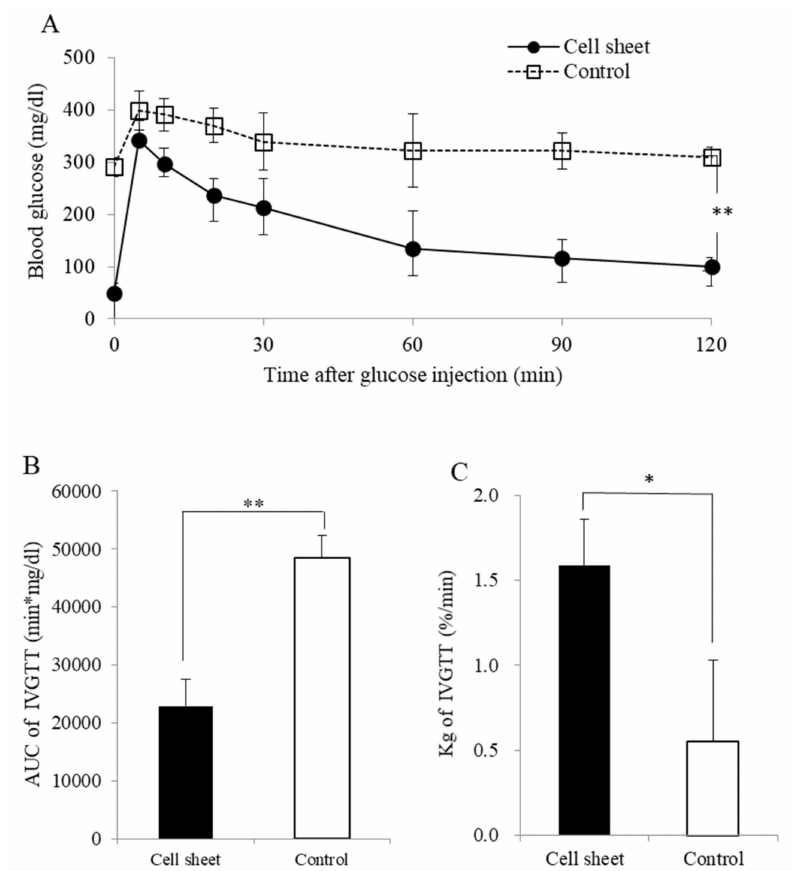
Figure 4. Profile of glucose tolerance of the cell sheet and control groups. ( A ) The blood glucose changes of the intravenous glucose tolerance test (IVGTT) (cell sheet group; black circle, n = 4, control group; white square, n = 4). ( B ) The area under the curve (** p < 0.01) and ( C ) Kg values (* p < 0.05) of the